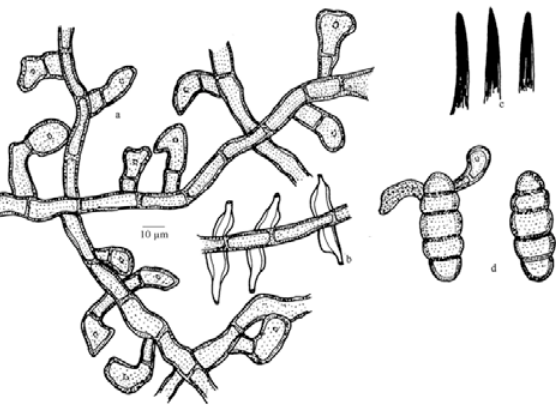
Figure 121. Meliola tecleae var. toddaliae-asiaticae a - Appressorium; b - Phialide; c - Apical portion of mycelial setae; d -